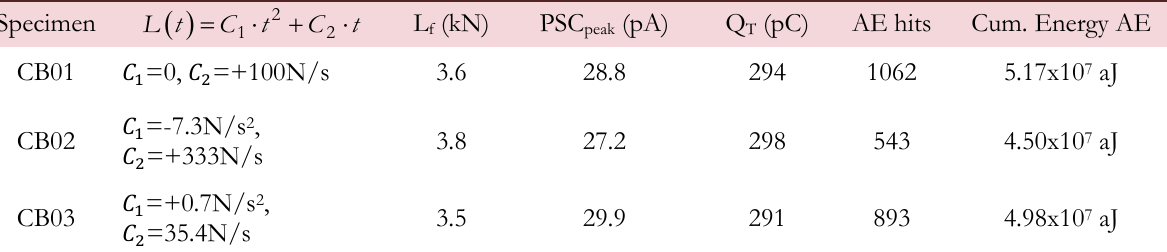
Table 1. The characteristics of the loading protocol followed during each of the three experiments conducted and the main quantities studied regarding the PSC and AE